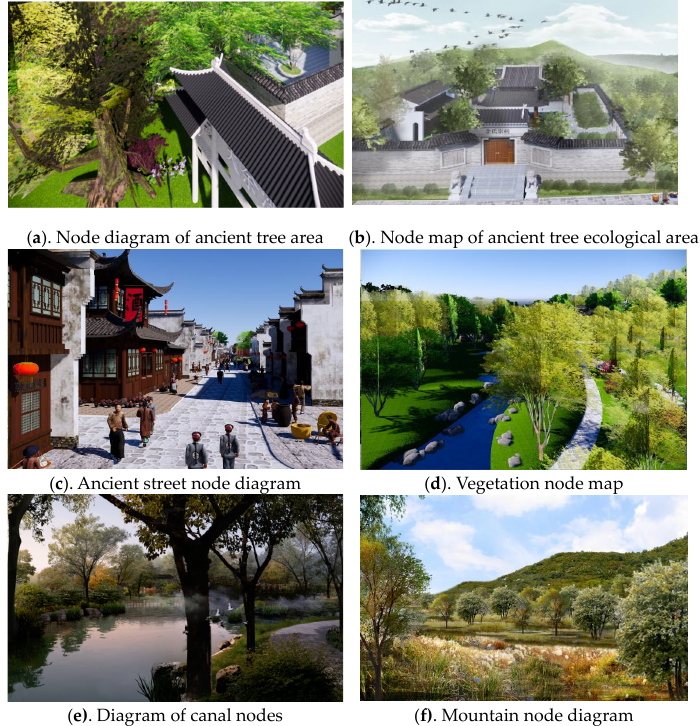
Figure 3. Design drawing of Dayu Bay. Source: Figures ( a – f ) are all virtual scene node diagrams drawn by the author.